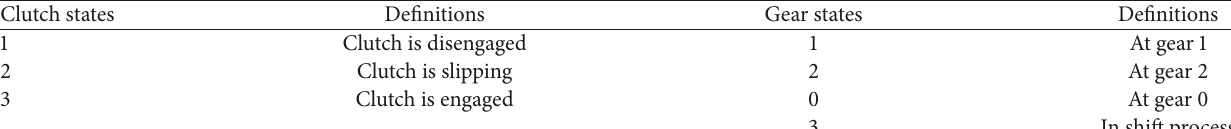
Table 2: Definitions of clutch and gear states.